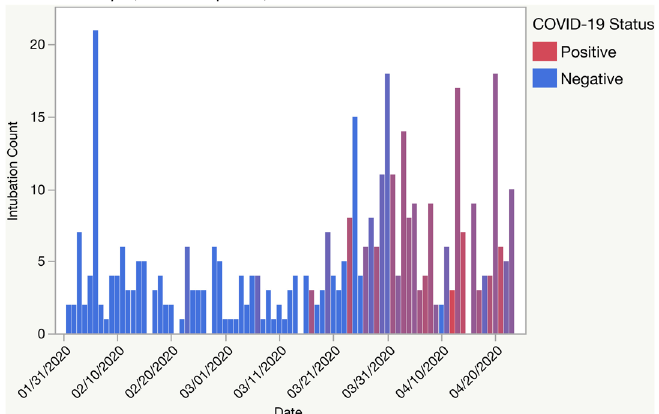
Figure 3. Count of non-operating room emergent intubations by date and COVID-19 test results at a single institution in